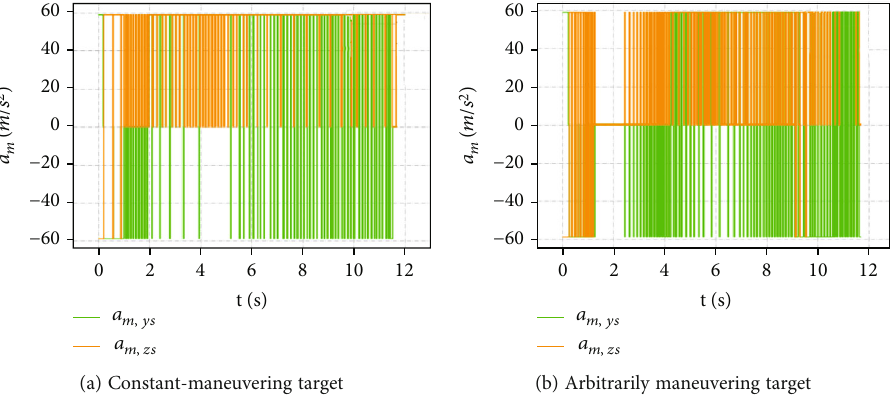
Figure 10: The engine switch curve of the exoatmospheric